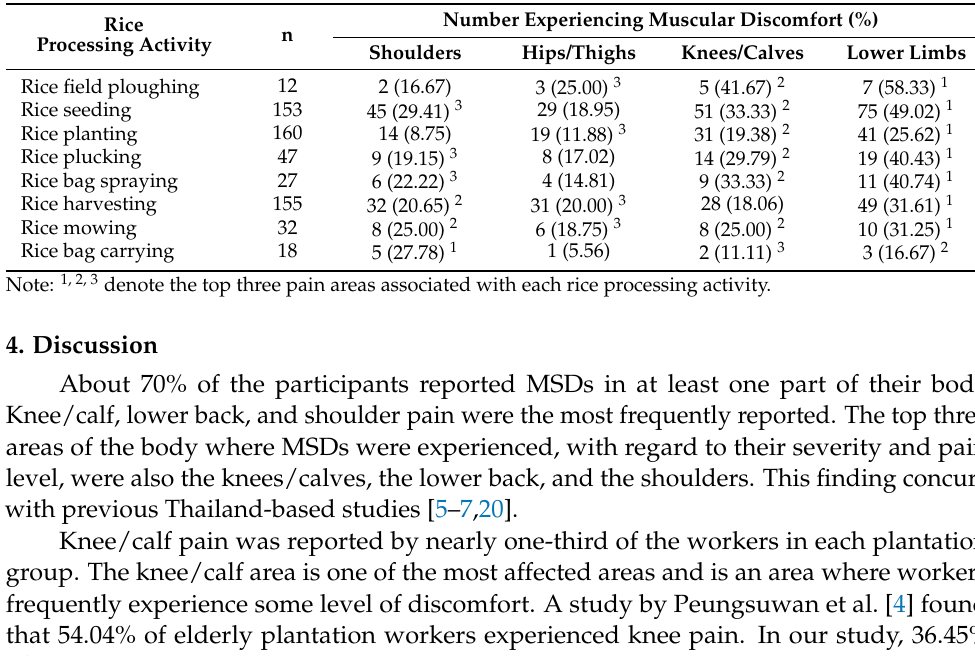
Table 3. MSDs experienced by rice cultivating agriculturalists according to rice processing activity (n =